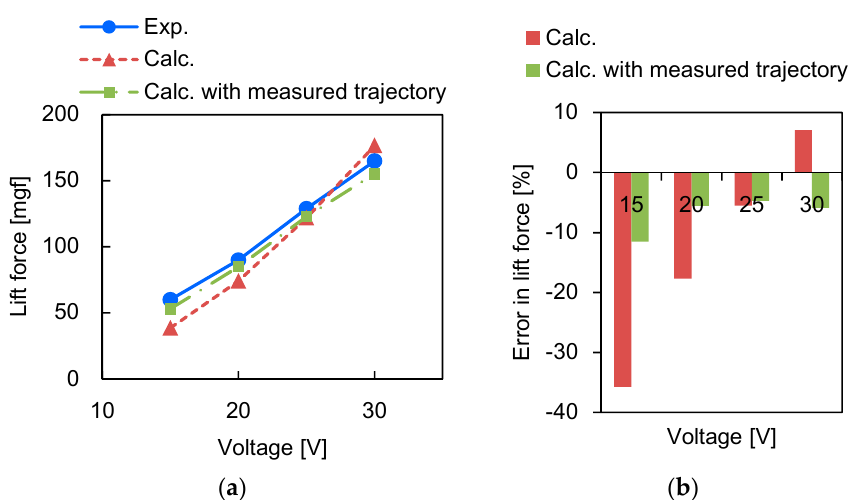
Figure 18. Comparison between fully analytical calculation and calculation based on measured trajectory of small-type actuator: ( a ) lift force and ( b ) error of lift force in experimental result.